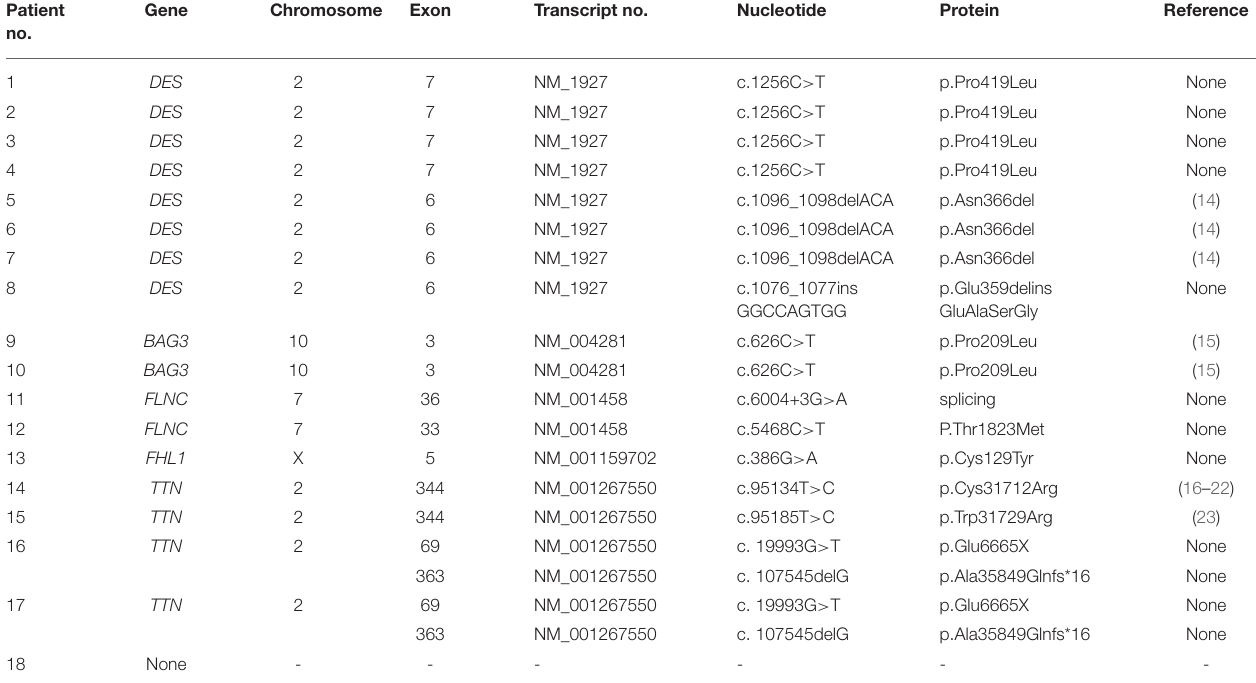
TABLE 1 | Genetics of the present MFM patient cohort. Patient